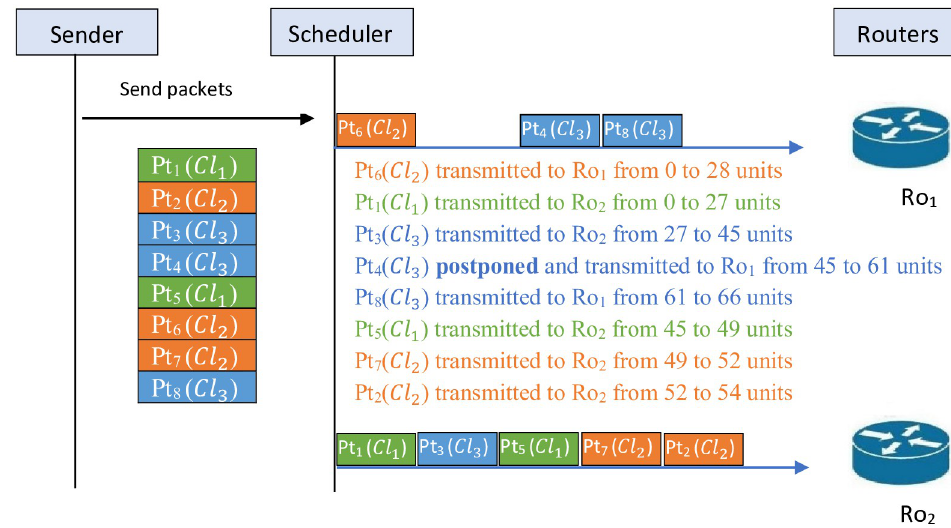
Fig 7. Schedule of LTF algorithm.